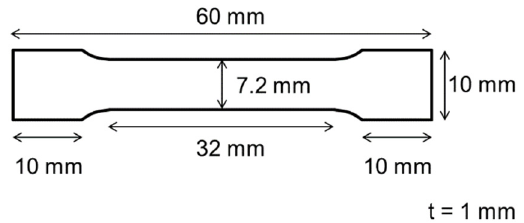
Figure 2. Dimensions of specimens for tensile tests.